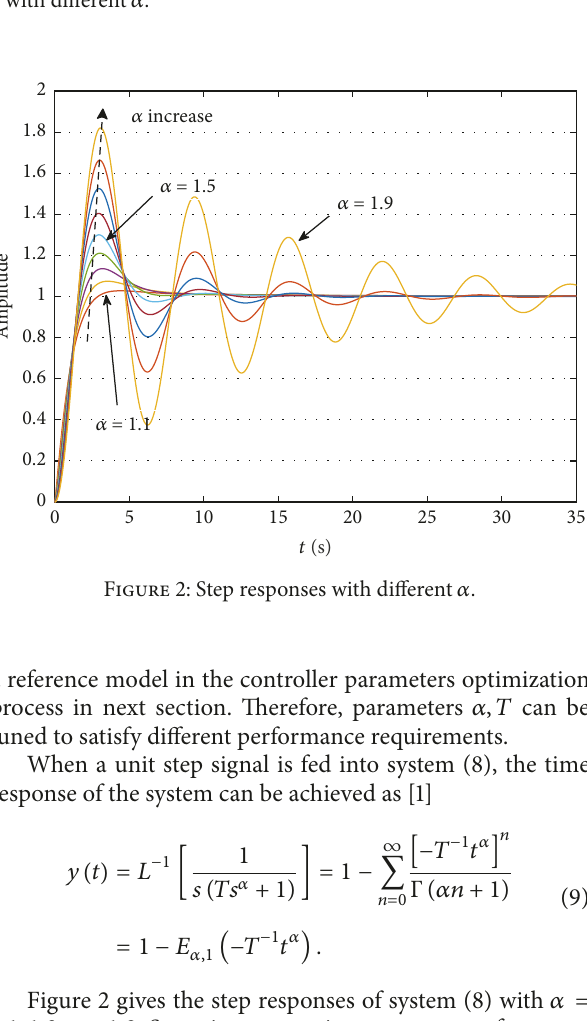
Figure 1: Bode diagram with different 𝛼 .